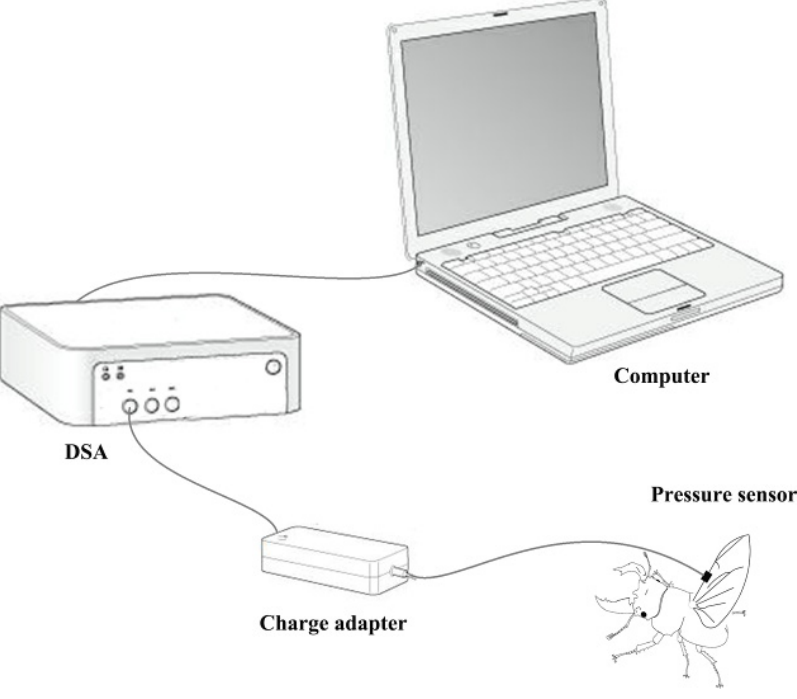
Figure 6. Schematic of the equipment used for measuring the change in blood pressure during expansion of